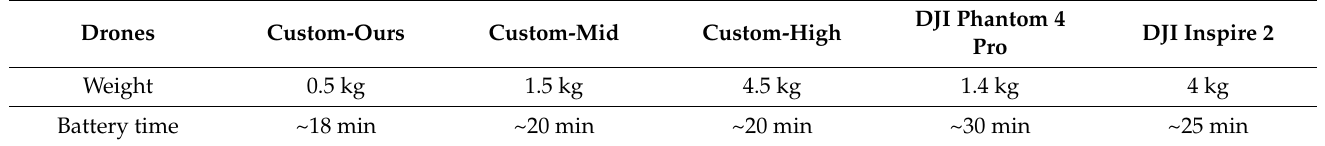
Table 3. Weight and battery time of